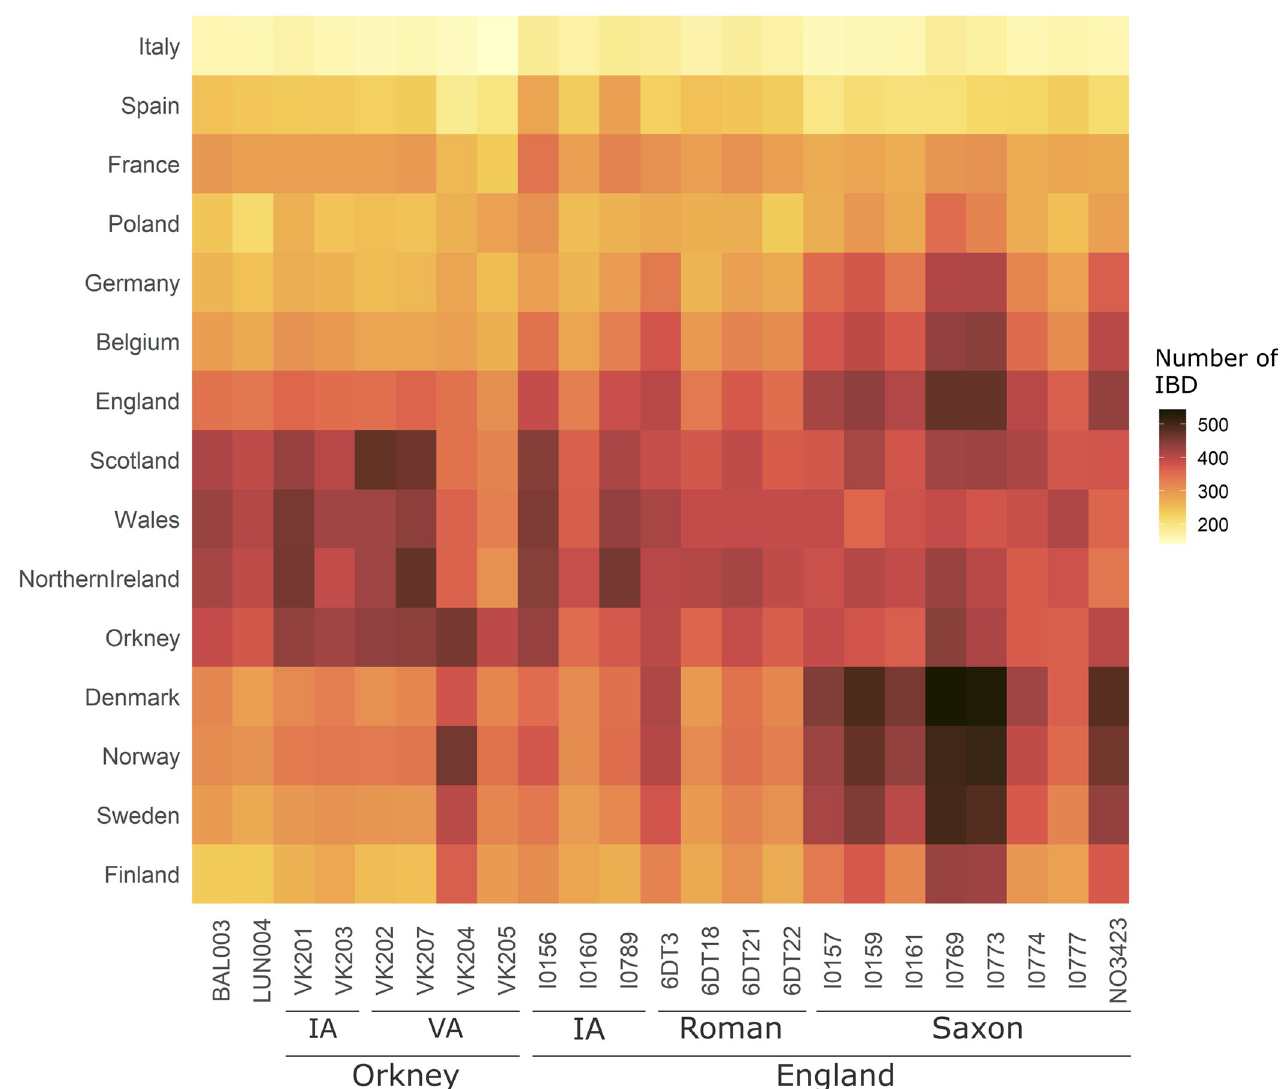
Fig 3. Shared Identity-By-Descent (IBD) segments > 1 cM between the ancient genomes from Britain and present-day European populations. IA, Iron Age. VA, Viking Age.